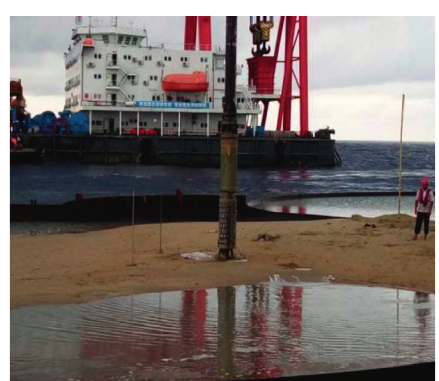
Figure 23: Positions of the three working ships.